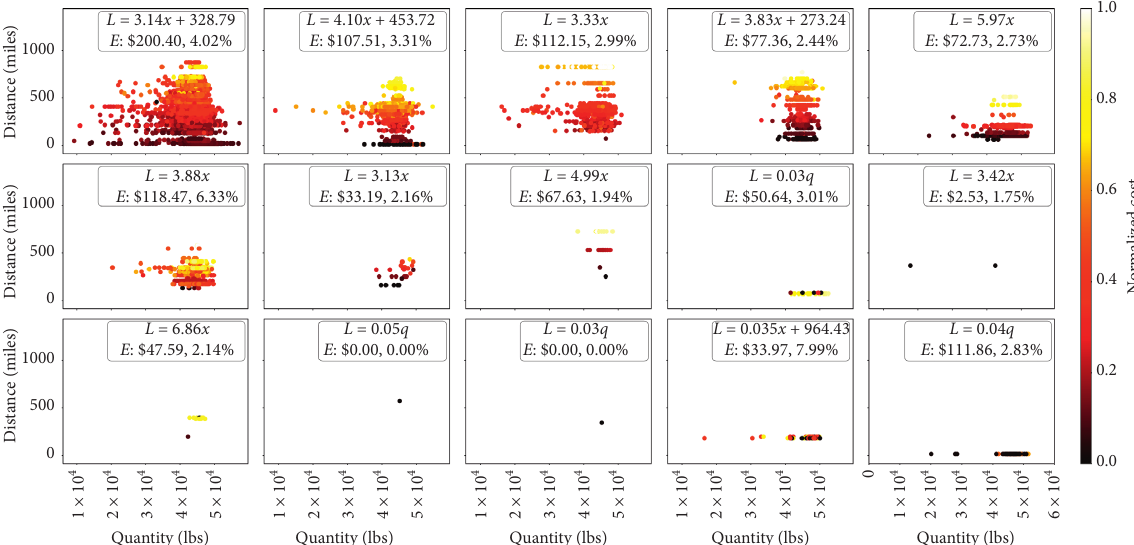
Figure 8: Distance versus quantity scatter plots for bulk truck carriers. Color indicates freight cost (key on right), normalized to [0, 1] for each carrier to have a minimum cost of 0 and a maximum cost of 1. Cost equations are obtained by performing regression analysis on each carrier. Weights are constrained to have positive values. In each cost equation (inset), L indicates the cost equation of the carrier, x denotes the distance in miles, q denotes the quantity in pounds, and E denotes the absolute error of the cost regression in dollars and as a percentage. Carrier names are omitted to preserve